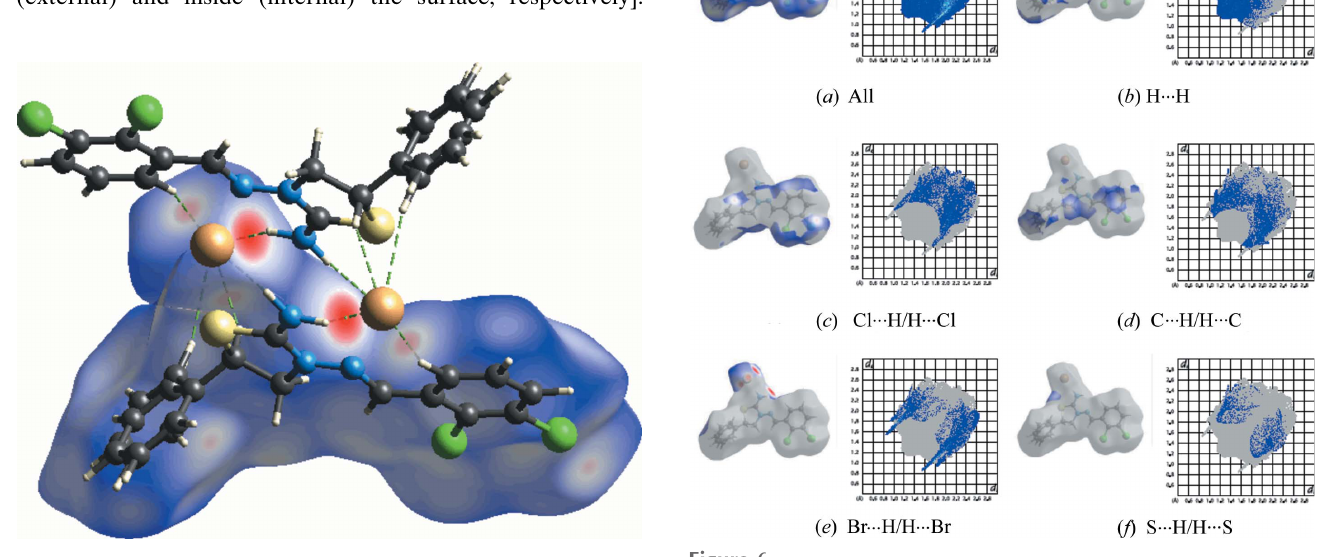
Figure 5 Hirshfeld surface of the title salt mapped with d norm , showing the C— H (cid:2)(cid:2)(cid:2) Br and N—H (cid:2)(cid:2)(cid:2) Br hydrogen